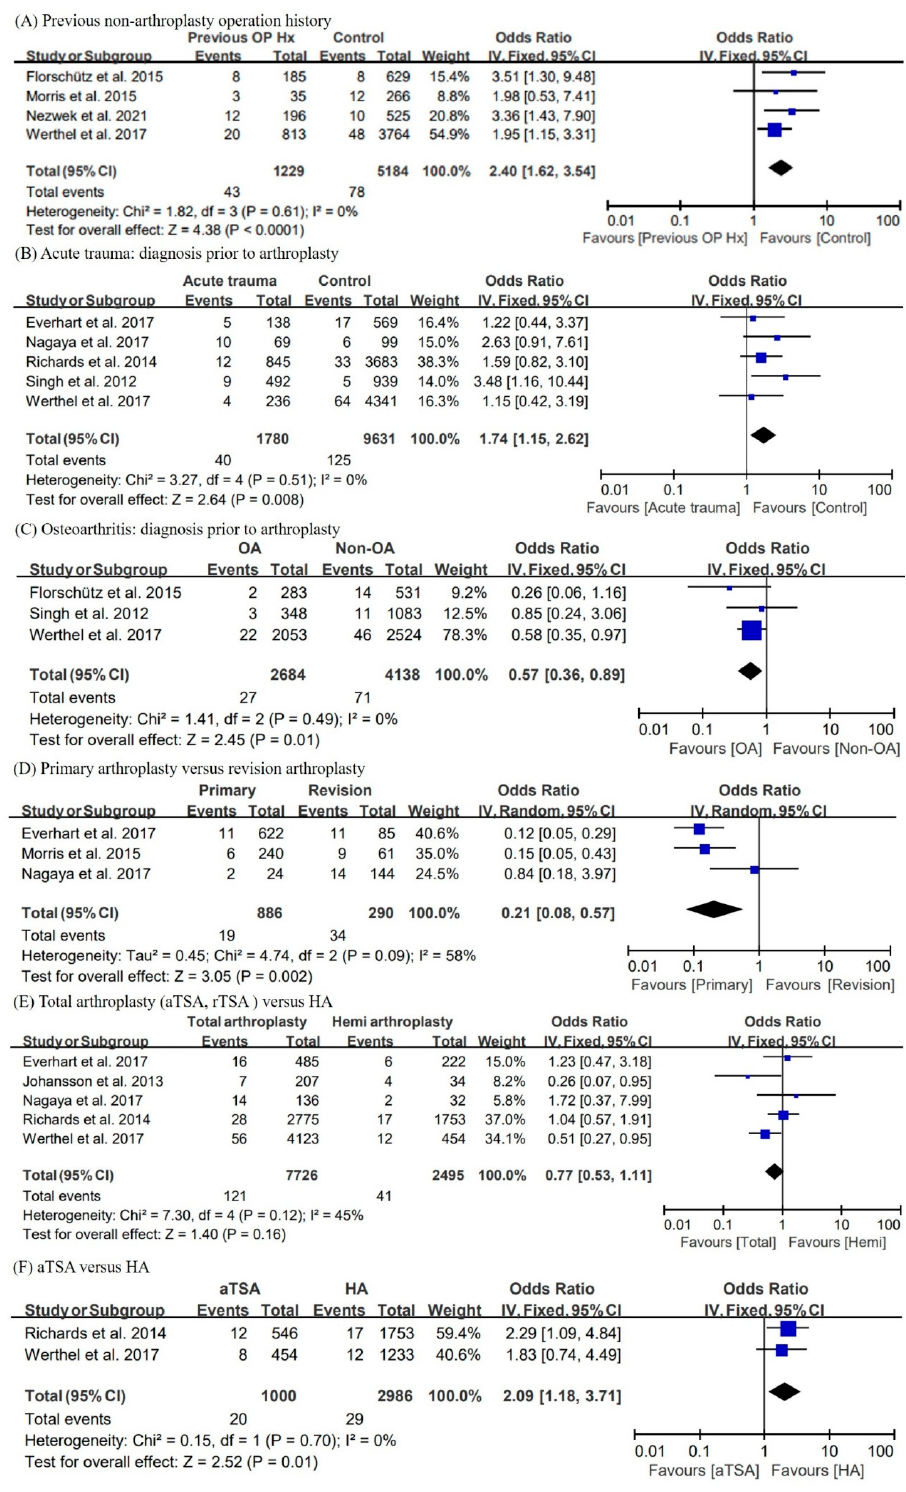
Figure 3. Forest plots, pooled odds ratio, 95% confidence interval, and heterogeneity for perioperative factors. The risk factors analyzed in the perioperative subgroups include ( A ) the presence of previous non-arthroplasty operation history, ( B ) acute trauma-related arthroplasty versus nontrauma-related arthroplasty, ( C ) OA as diagnosis prior to arthroplasty versus non-OA, ( D ) revision arthroplasty versus primary arthroplasty, and ( E ) total shoulder arthroplasty (aTSA and rTSA) versus hemiarthro- plasty. OP Hx, operation history; OA, osteoarthritis; aTSA, anatomical total shoulder arthroplasty; rTSA, reverse total shoulder arthroplasty; HA, hemiarthroplasty